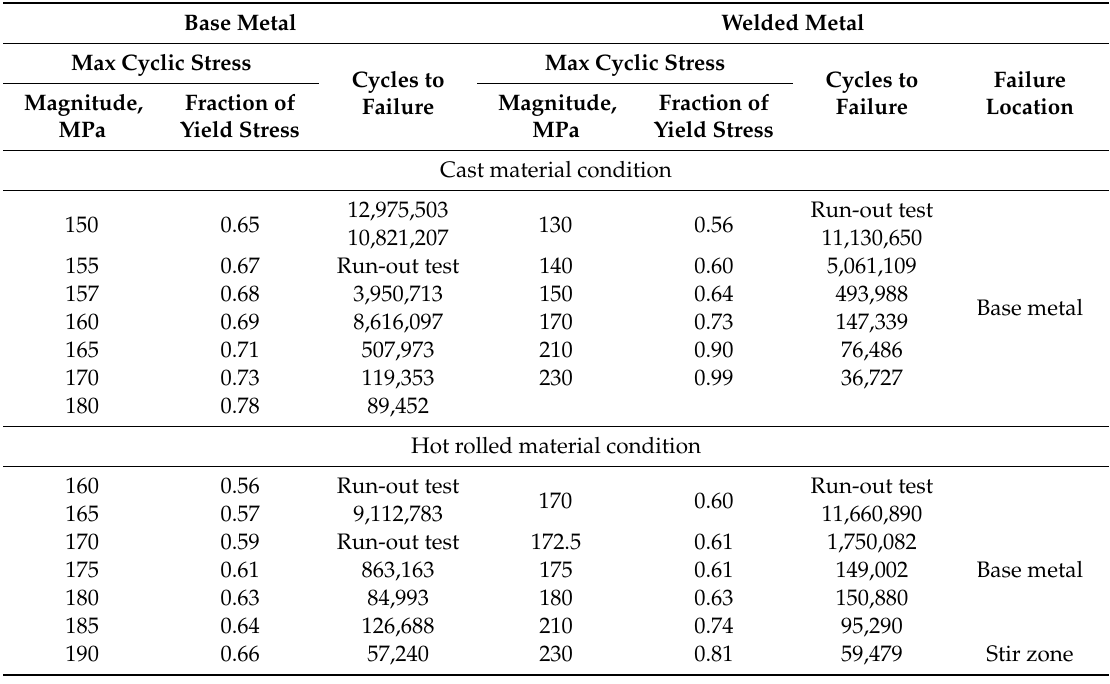
Figure 5. Fatigue lifetime versus maximal cyclic stress per cycle for base material and friction-stir joints in ( a ) Al-Mg-Sc alloy with the initial cast condition, ( b ) Al-Mg-Sc alloy with the initial hot-rolling condition, and ( c ) 6061 alloy. In the figures, solid lines represent median curves, whereas dotted lines show 95% confidence bands. Arrows indicate run-out tests. Table 5. Results of fatigue tests of Al-Mg-Sc